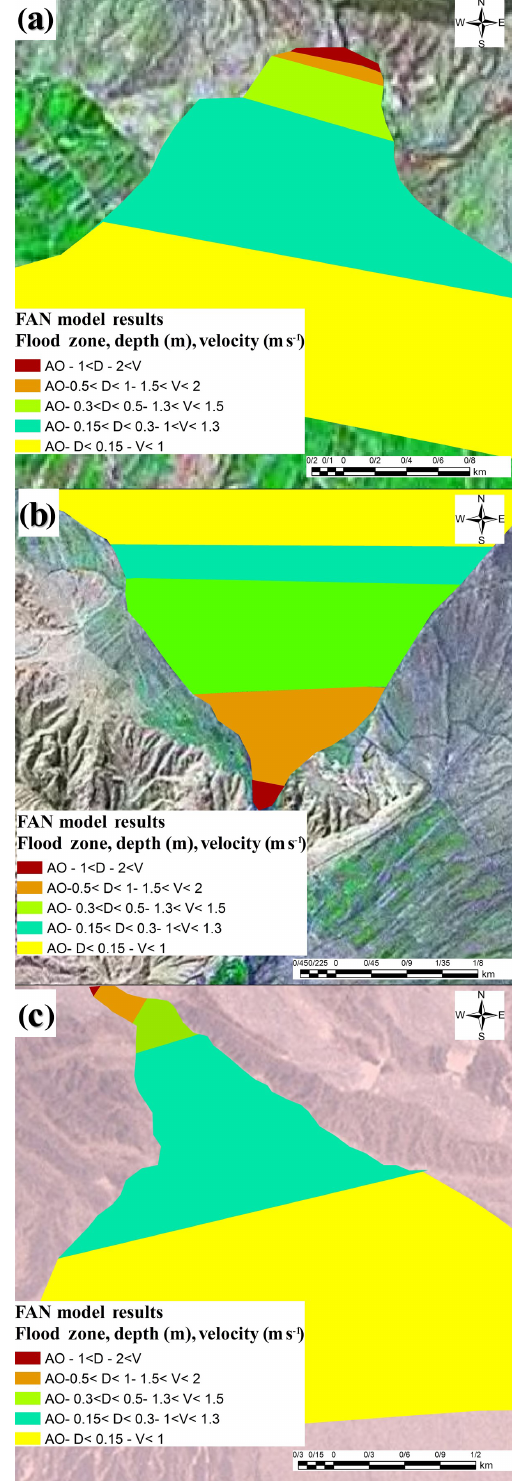
Figure 7. Flood depth and velocity results of the FAN model for